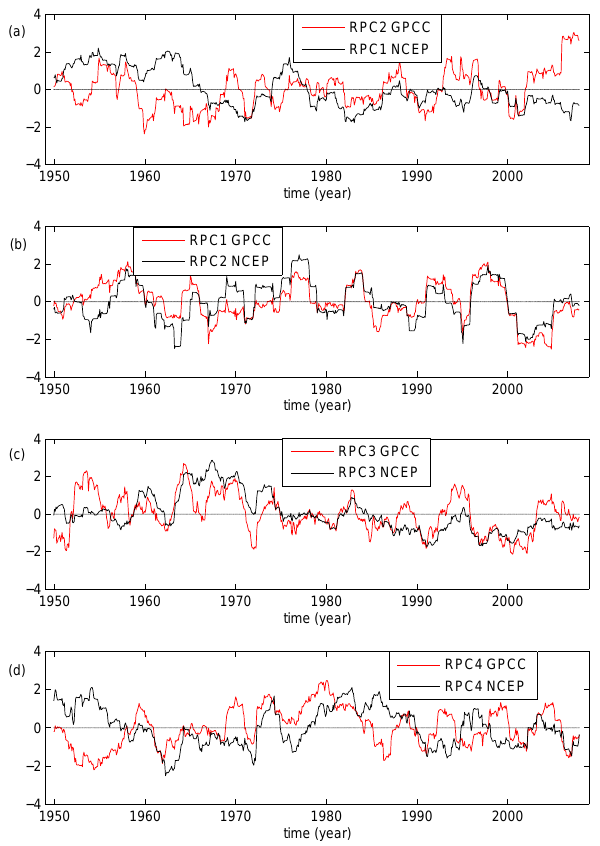
Fig. 6. First four rotated PC score time series (RPCs) of the SPI on 24-month time scale associated with the same sub-regions for NCEP/NCAR (black lines) and GPCC (red lines) datasets for the common period